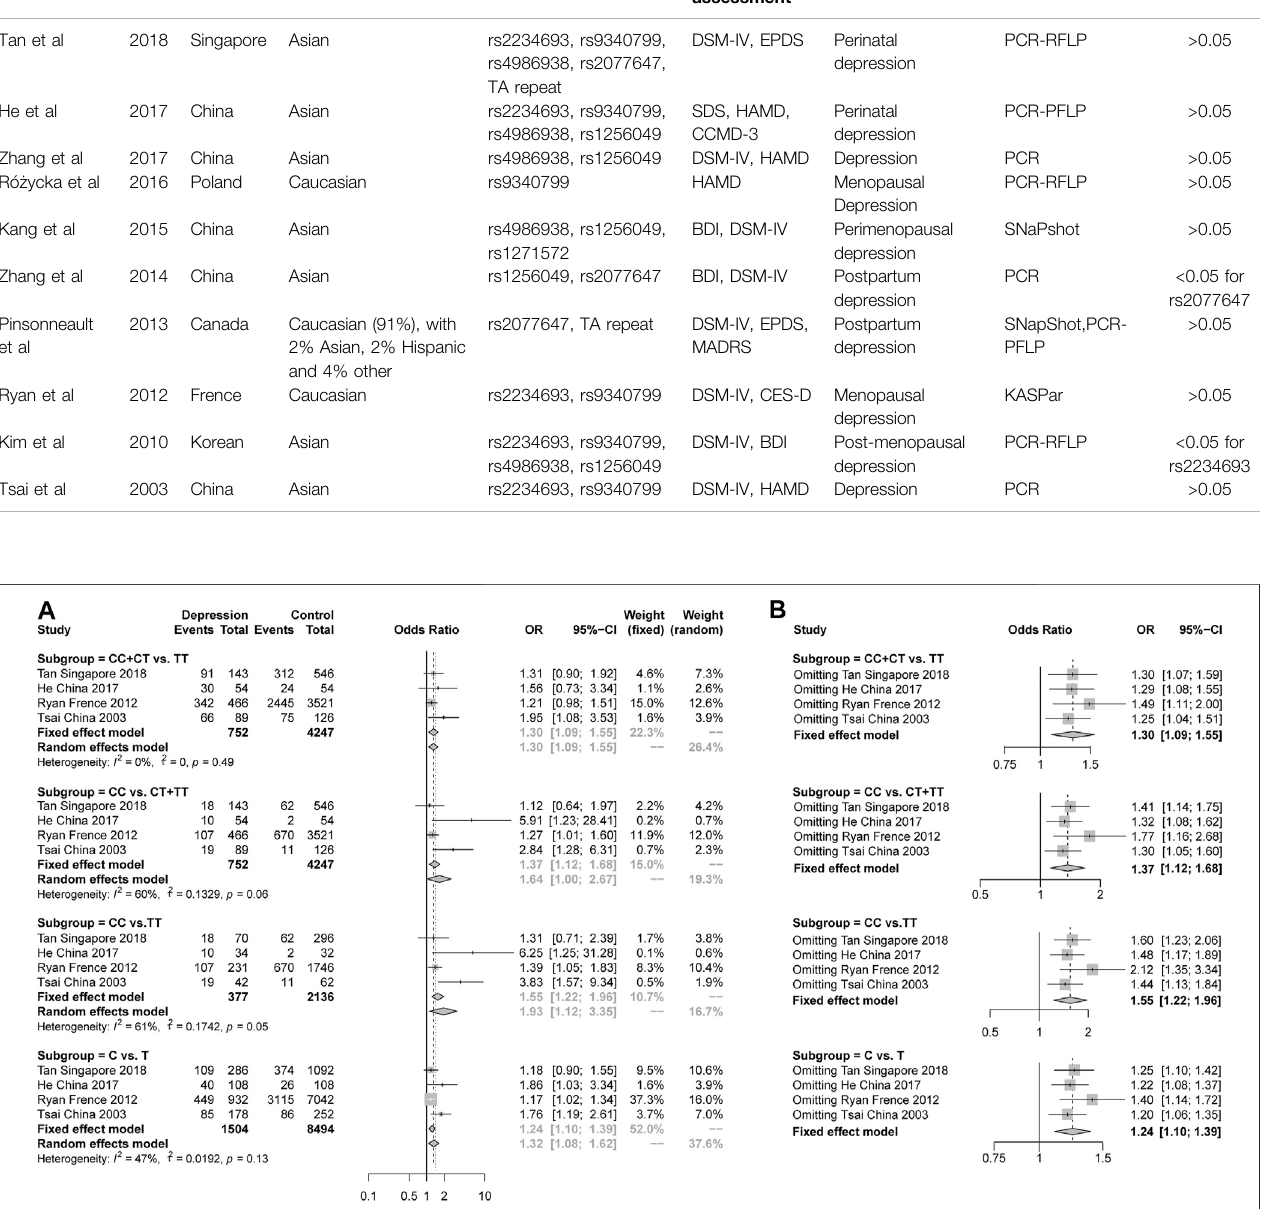
FIGURE2|(A) ,Forestplotofstudiescomparingtheriskofthers2234693polymorphismofER α betweenwomenwithdepressionandcontrols; (B) ,Meta-analysis with a fi xed-effects model with individual studies